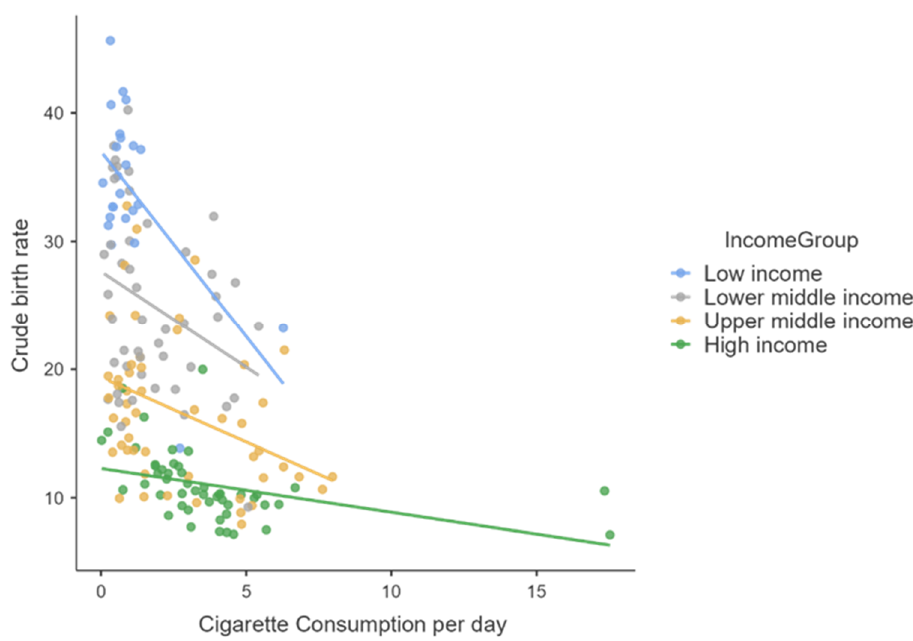
Figure 1. The correlation between the number of cigarettes consumed daily per capita and the crude birth rate.